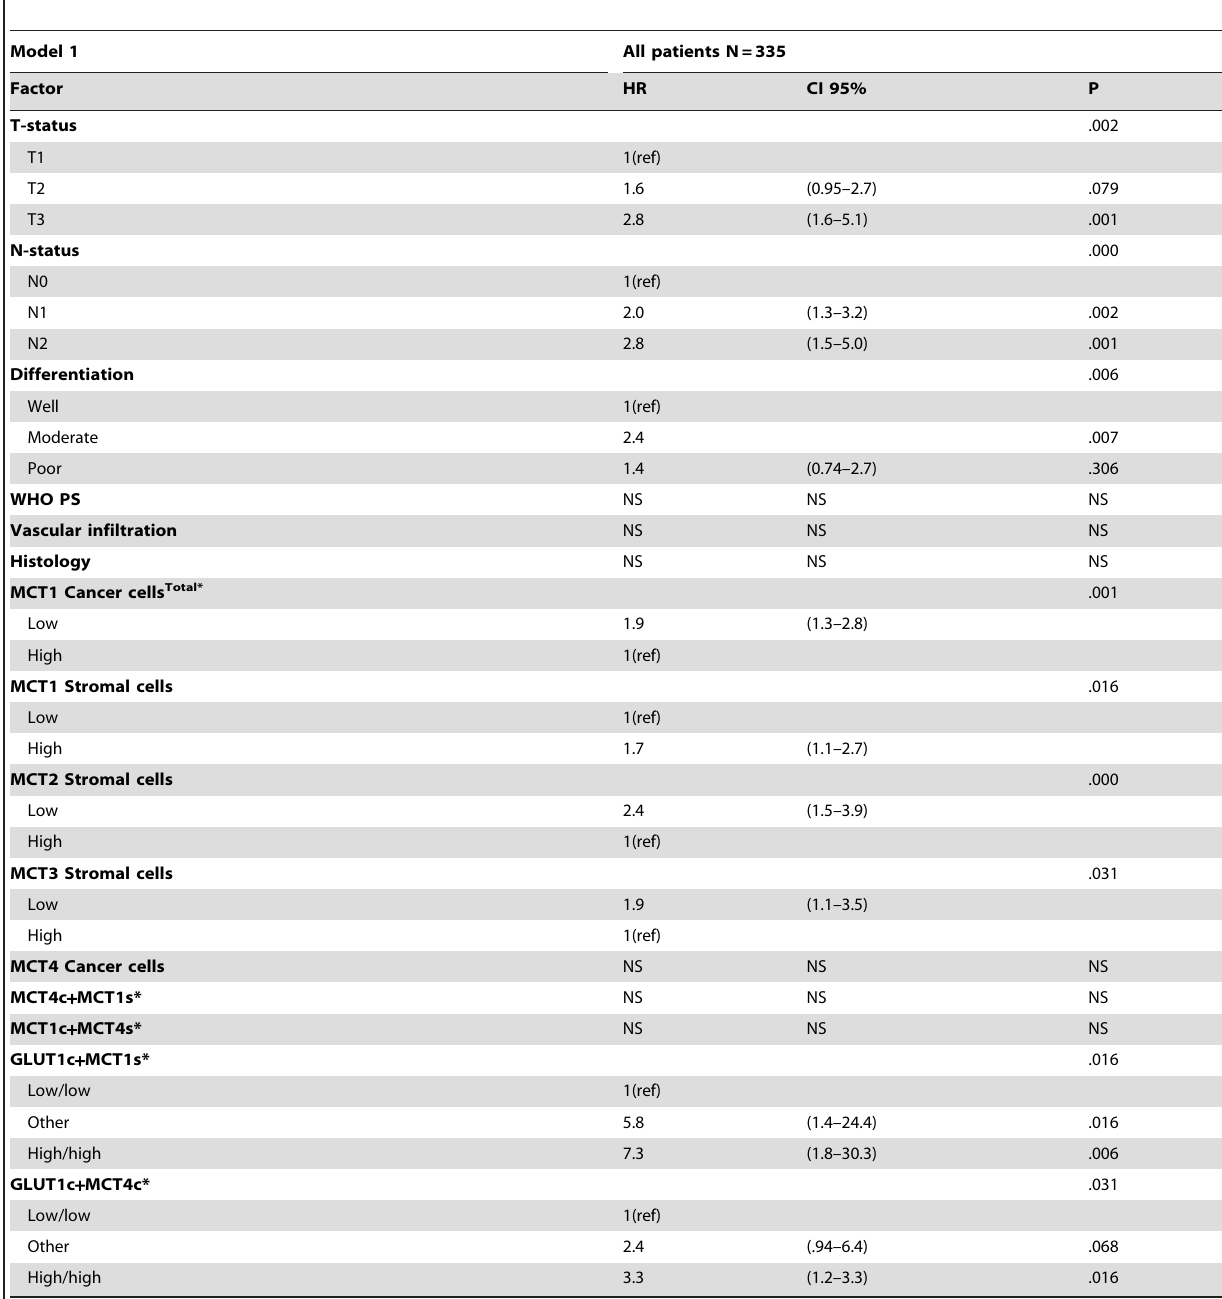
Table 4. Results of Cox regression analyses (backward stepwise model) for clinicopathological factors and monocarboxylate transporters (MCTs) (model 1) and metabolic co-expression variables (*model